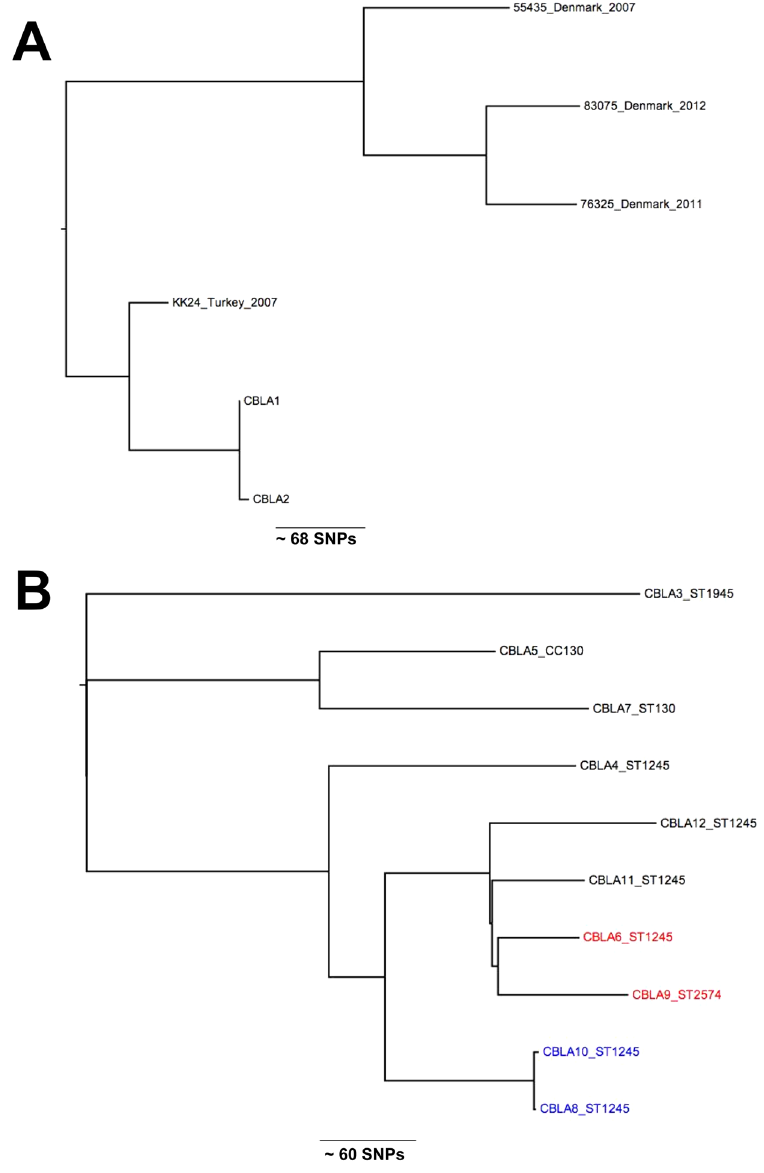
Figure 1. ( A ) Phylogenetic relationships between Cambridgeshire CC97 isolates and most closely related isolates from a global collection 10 . Figure shows an unrooted maximum likelihood tree generated from core genome single nucleotide polymorphisms. ( B ) Phylogenetic relationships between Cambridgeshire CC130 isolates. Figure shows an unrooted maximum likelihood tree generated from core genome single nucleotide polymorphisms. The two clinical isolates are highlighted in red. The two closely related isolates from the same patient are highlighted in